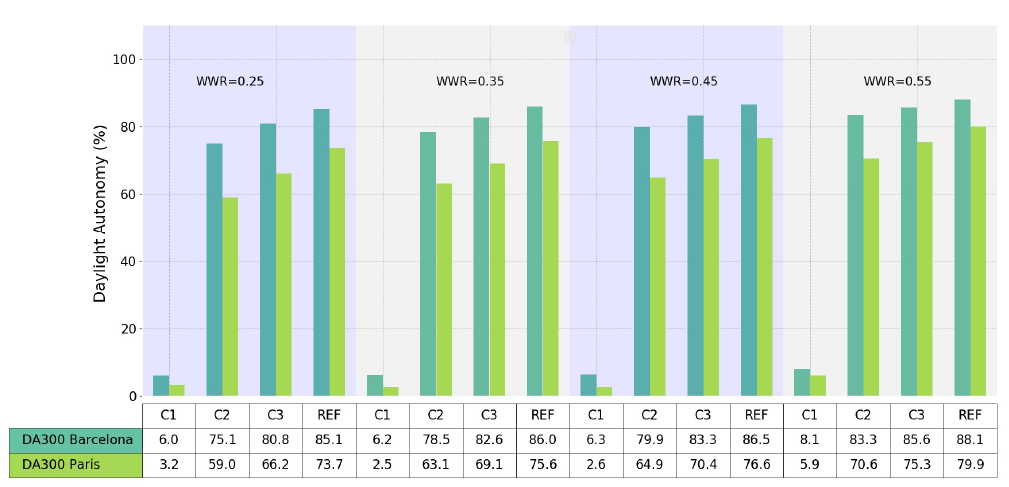
Figure 8. Daylight autonomy (DA) (300 lux) for the different configurations in Barcelona and Paris.